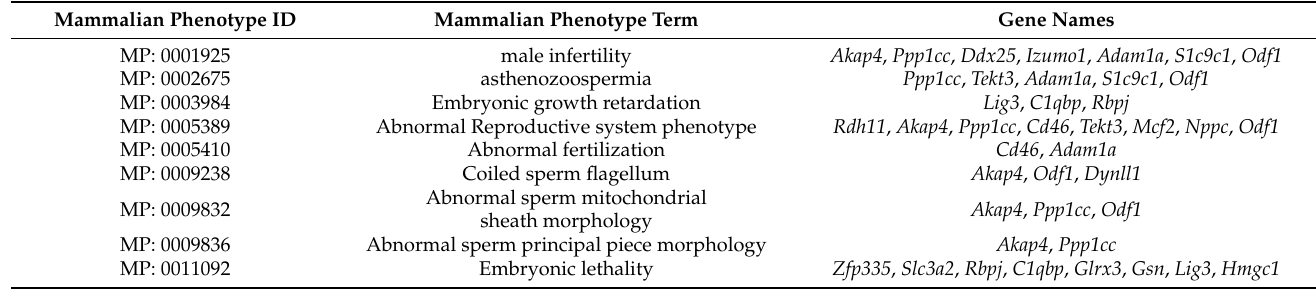
Table 2. Mammalian phenotype terms for DEPs in buffalo spermatozoa.